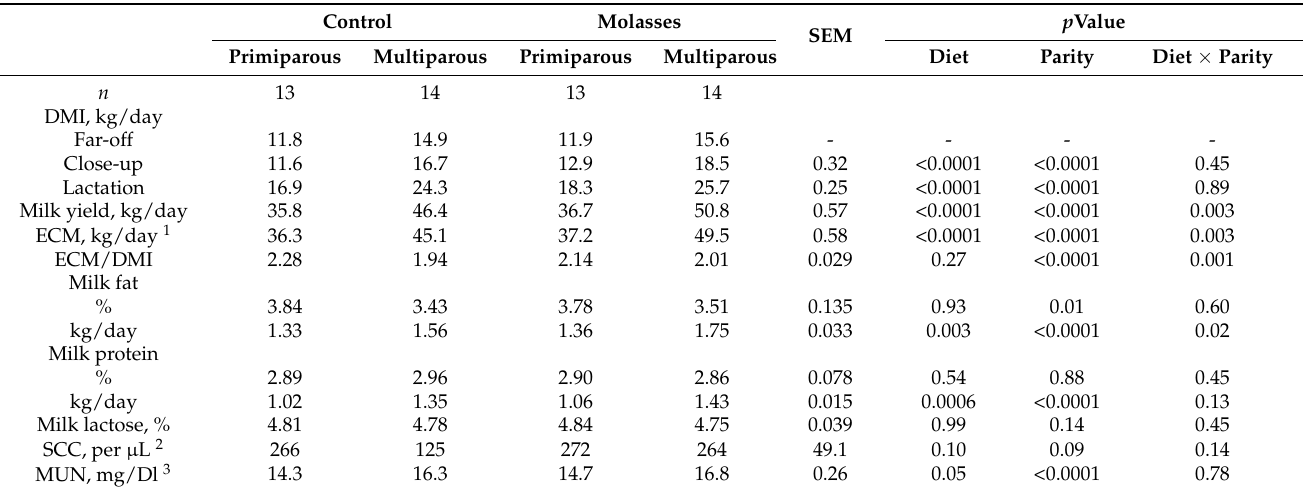
Table 2. Dry matter intake (DMI) and milk yield and composition during the initial 60 days of lactation for primiparous and multiparous cows fed control or molasses-containing diets during a 60 day dry period (Experiment